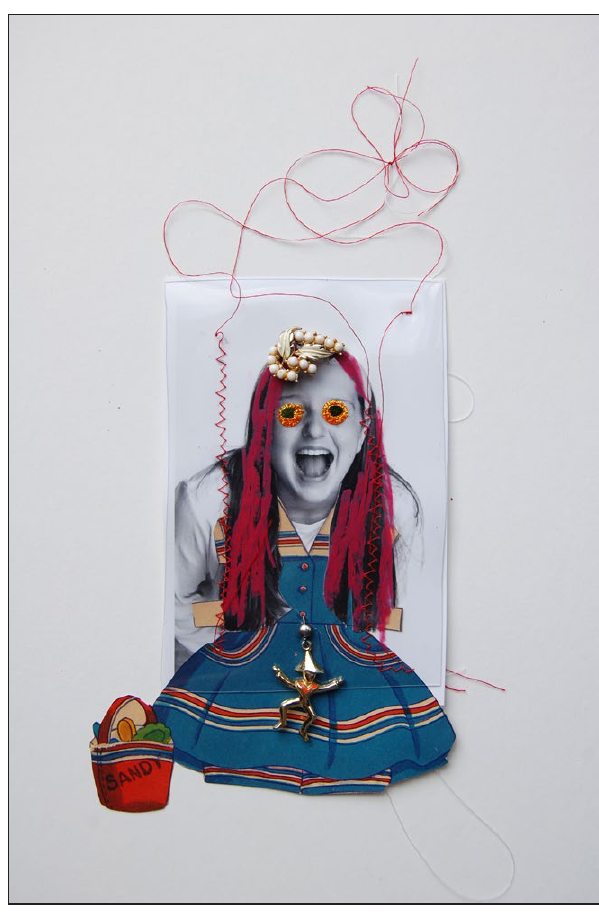
Figure 6: Brain Candy: Sandy,